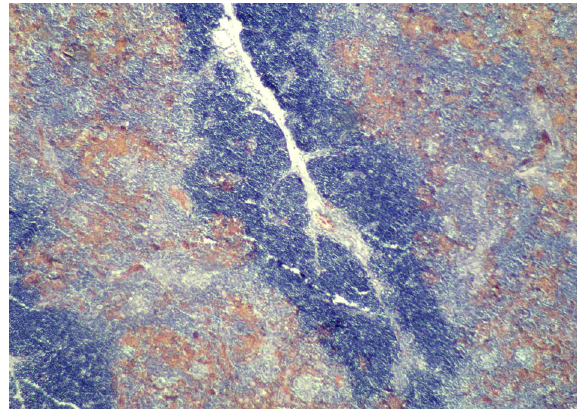
Fig. 4. Enlargement of the medulla, stagnation in the broiler chicken’s thymus, the 4 th group, the 30 th day of the test.